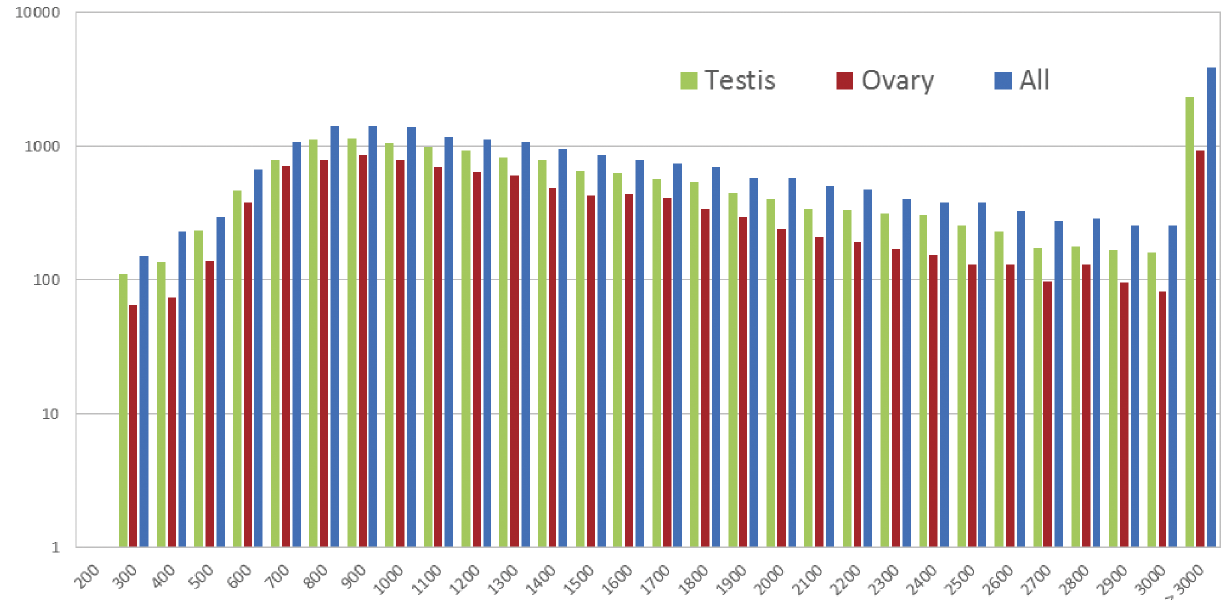
Figure 1. Assembly quality statistics of testis, ovary, and all isotigs from 454 sequencing. Length distribution of de novo assemblies of isotigs (x-axis indicates the sequence size (nt), y-axis indicates the number of assembled isotigs).